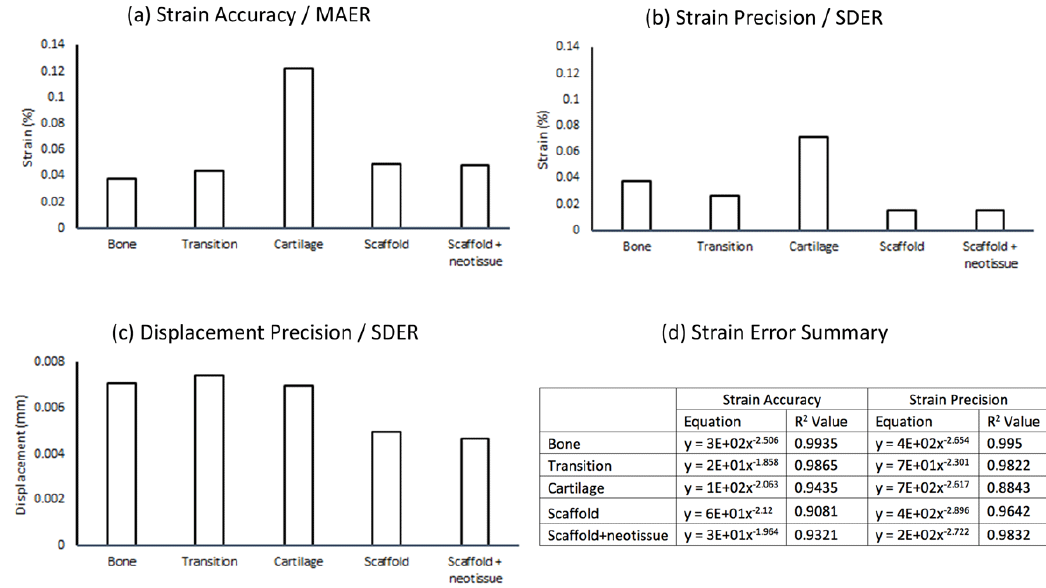
Figure 6. Quantification of error for five components of the tissue-biomaterial system for the evaluated sample (n = 1) at a subvolume size of 80 voxels (360 µm) using the FFT + DC method: ( a ) Strain accuracy ( b ) Strain precision ( c ) Displacement precision ( d ) Power law relationships computed for the FFT + DC method across all tested subvolume sizes for the system components where y represents the error metric and x represents the subvolume size.